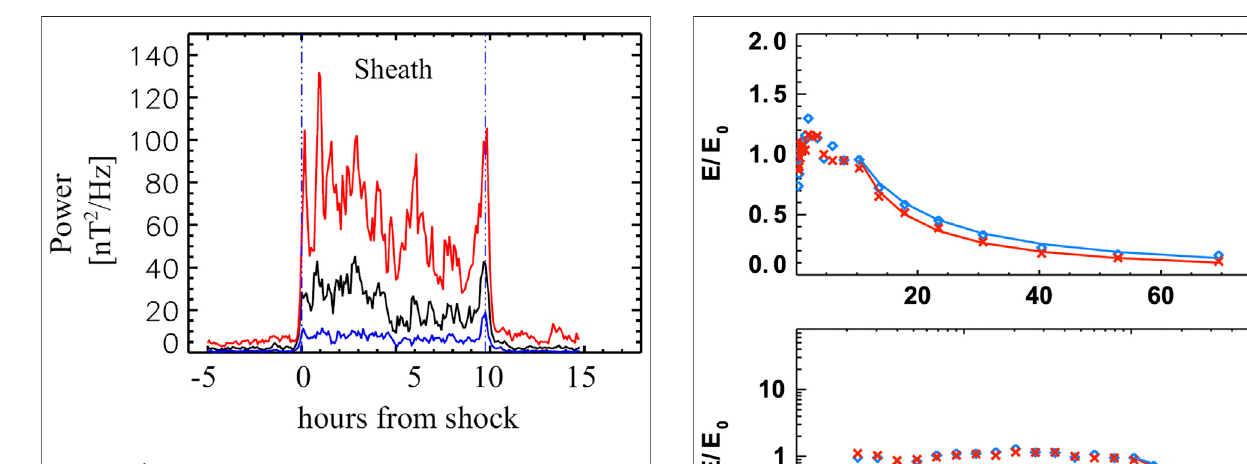
FIGURE 8 | ULF power of B z component of IMF in sheaths of ICMEs (superposed analysis ofsheath pro fi les that have been re-scaled to10 h). The black line in the middle shows the median while the red and blue lines denote the upper and lower quartiles, respectively. For details, see [66]. The fi gure is adapted from [63]; copyright by Springer Nature, licensed under CC BY 4.0.